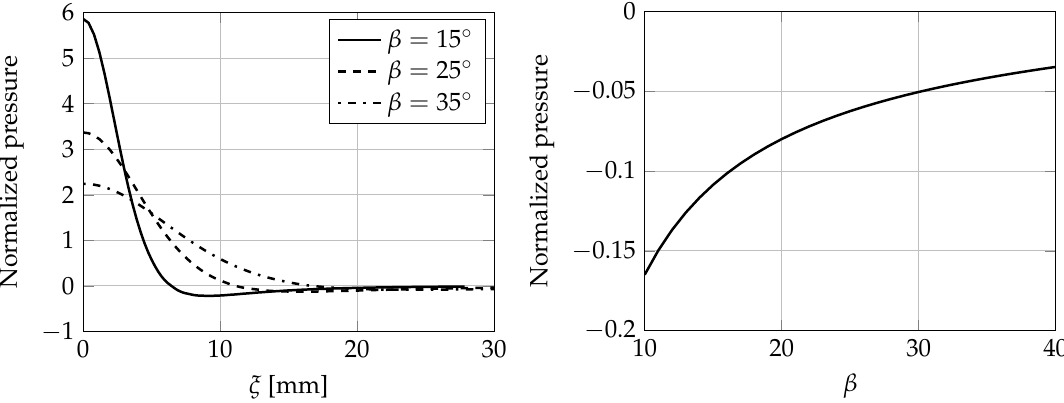
Figure 2. Wagner’s predicted normalized pressure as a function of the normalized wet length x / r at several instants. The solution was calculated for a wedge weighing 5 kg/m, with a 20 ◦ deadrise angle, entering the water at 2 m/s with pure vertical velocity.